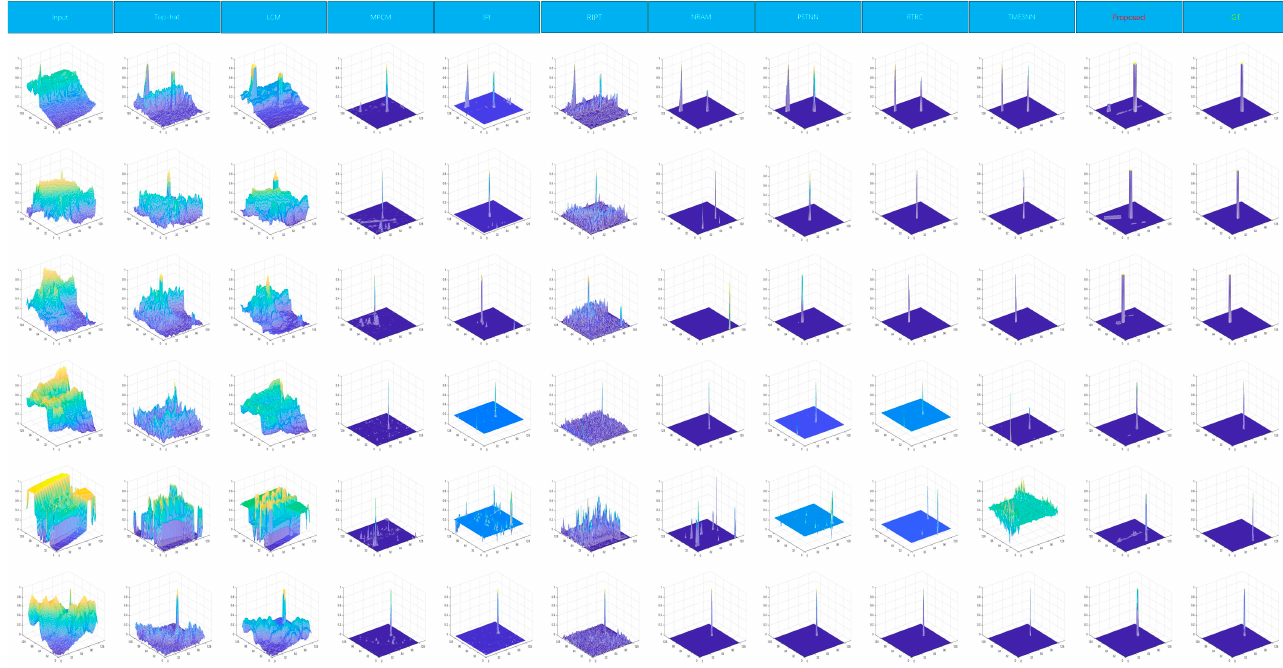
Figure 9. 3D visualization of results of different methods on six test images.